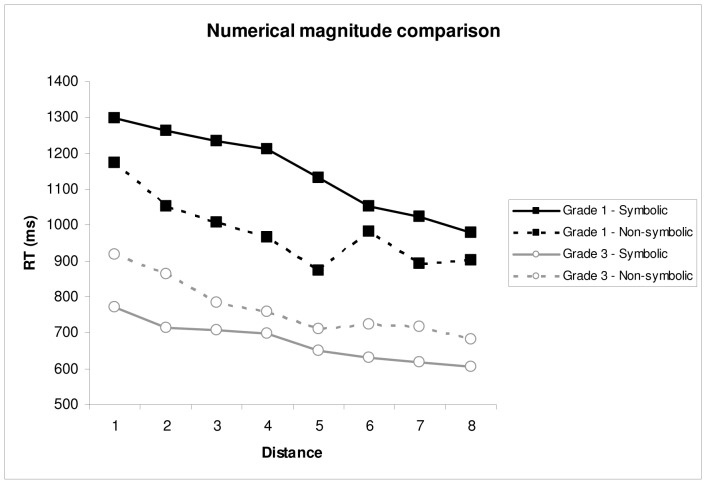
Mean reaction time (based on correct responses only) on the numerical magnitude comparison tasks as a function of grade and distance.Solid lines indicate data on the symbolic magnitude comparison task (M
Grade 1 = 1199.71 ms; M
Grade 3 = 698.65 ms), and dashed lines indicate data on the non-symbolic magnitude comparison task (M
Grade 1 = 1013.28 ms; M
Grade 3 = 799.62 ms).